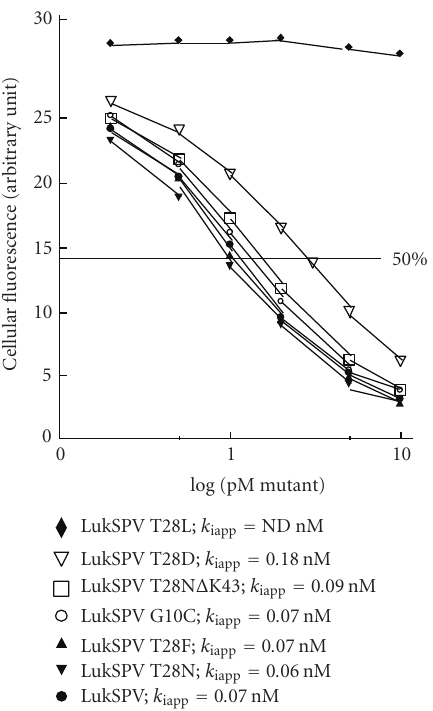
Figure 5: Competition between the fluorescent LukS-PV G10C and the mutated proteins and their binding to the cell, recorded by flow cytometry.